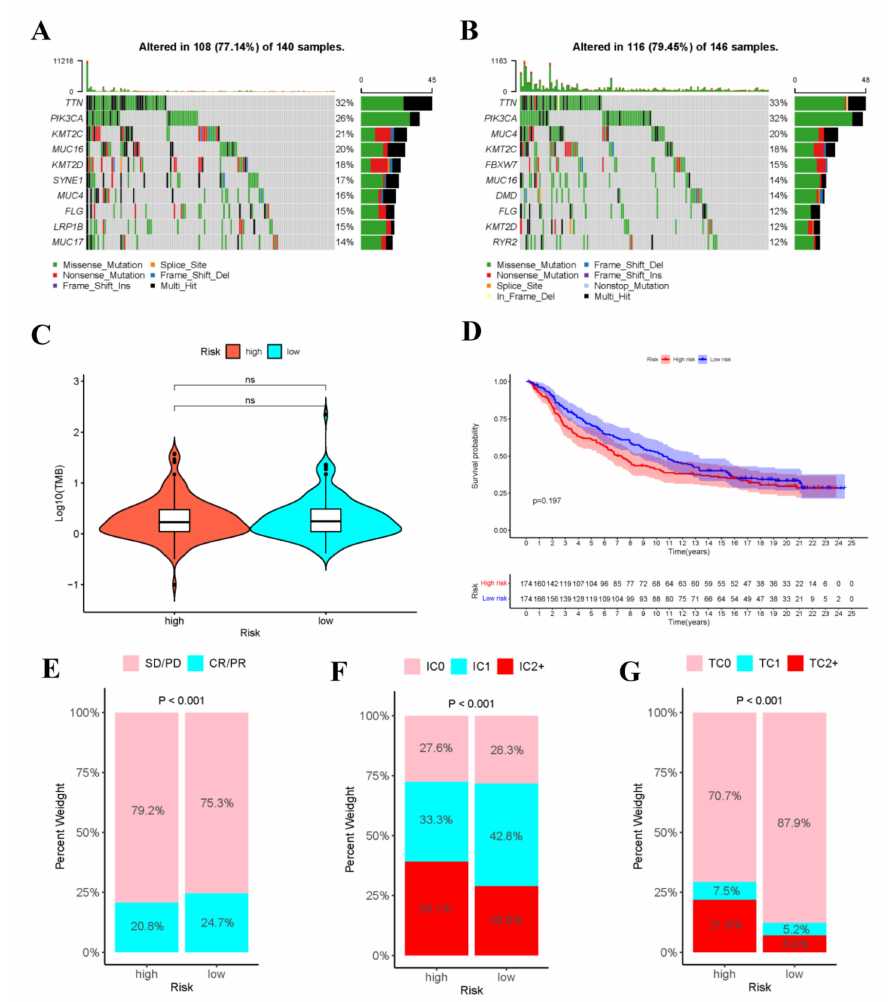
Figure 11. Analysis of tumor mutations and immunotherapy cohort analysis. Oncoplot shows the sample gene mutation landscape for the high-risk ( A ) and low-risk ( B ) groups, the genes are sorted according to their mutation frequency. Violin plots shows no difference in TMB between high- and low- risk groups ( C ). ( D )The K–M survival curves of high- and low- risk groups in the IMvigor210 Cohort. ( E ) Rate of clinical response (complete response [CR]/partial response [PR] and stable disease [SD]/progressive disease [PD]) to anti-PD-L1 immunotherapy in high- or low-risk groups in the IMvigor210 cohort. ( F ) Level of IHC-assessed PD-L1 staining on immune cells (IC) in high- or low- risk groups in the IMvigor210 cohort, with IC0 meaning < 1 percent, IC1 ≥ 1 percent but <5 percent, IC2+ ≥ 5 percent immune cells staining for PD-L1. ( G ) Level of IHC-assessed PD-L1 staining